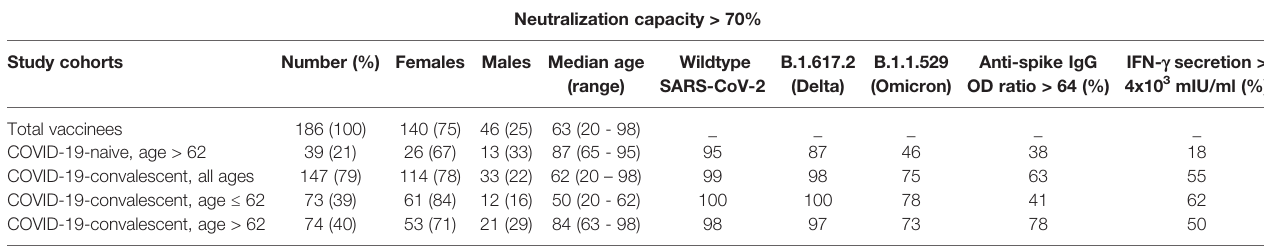
TABLE 1 | Age, gender and key immunological response parameters of study cohorts after 3 rd vaccination with